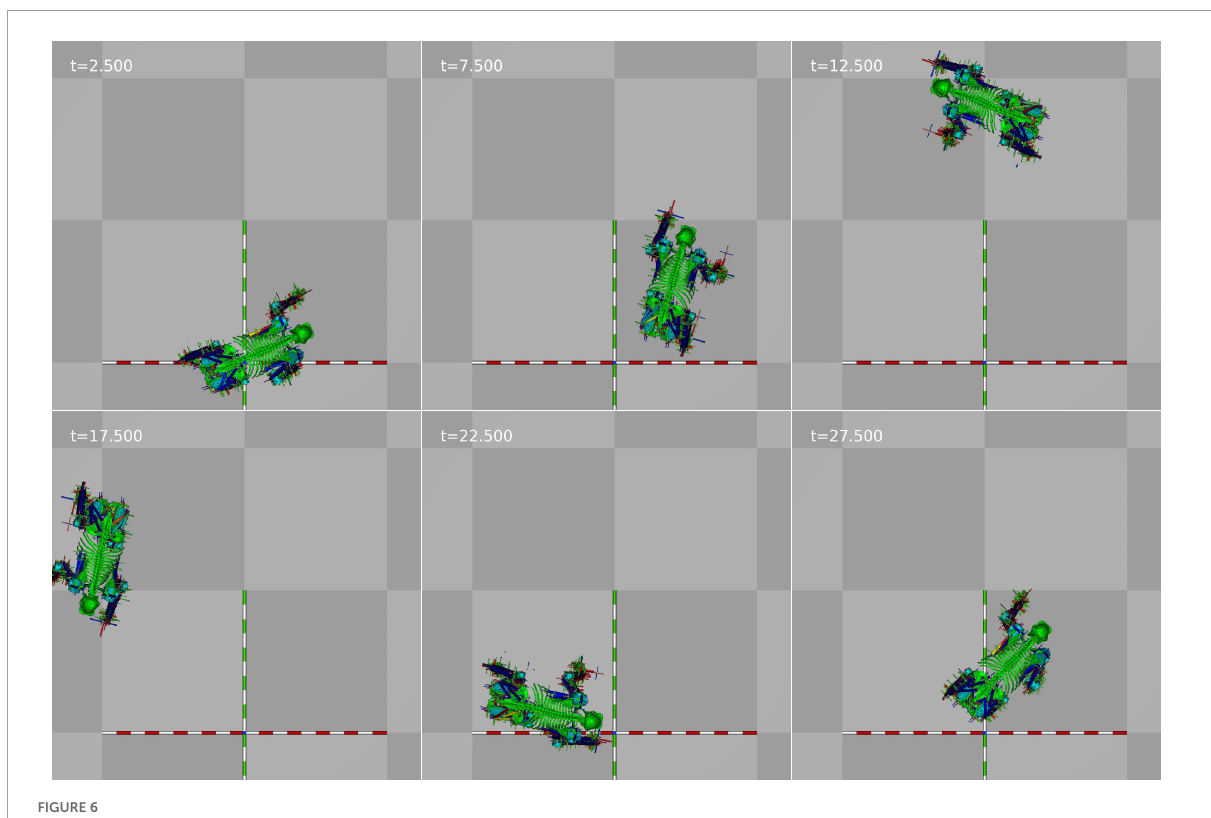
FIGURE6 Still frames from the turning animation at 5 s